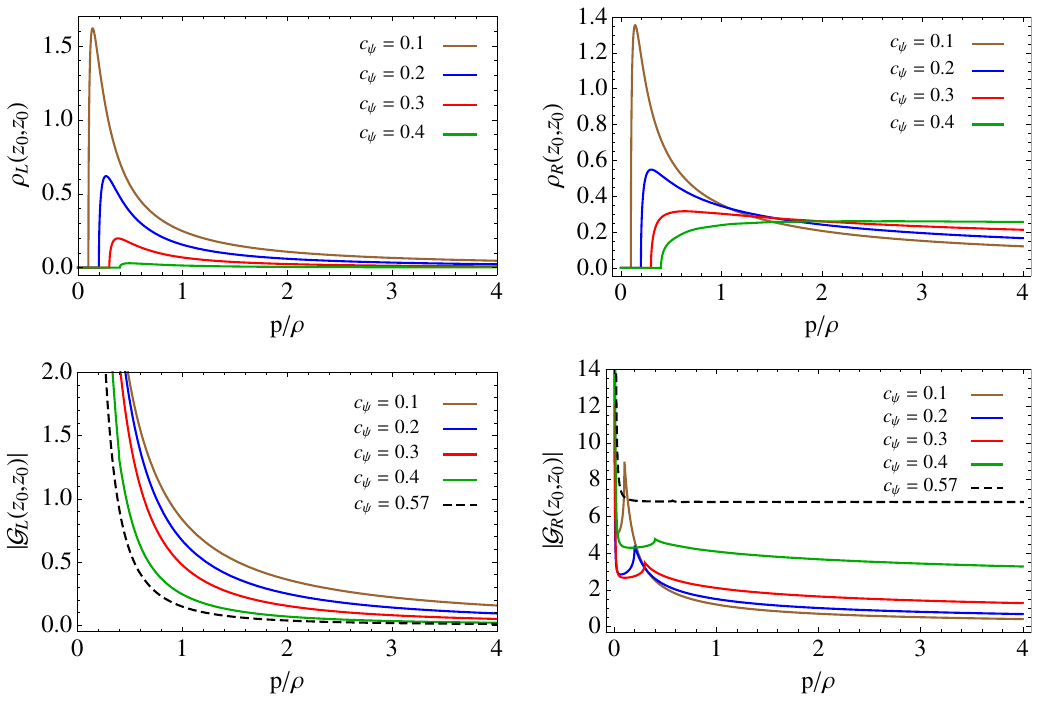
Figure 6 . Upper panels: spectral density for a continuum left-handed fermion, cf. eq. (5.37) (left panel), and a continuum right-handed fermion, cf. eq. (5.39) (right panel). We have used c = 0 : 1 ; 0 : 2 ; 0 : 3 and 0 : 4. Lower panels: absolute value of the Green’s functions for a continuum left-handed fermion (left panel), and a continuum right-handed fermion (right panel). We have used c = 0 : 1 ; 0 : 2 ; 0 : 3 ; 0 : 4 (solid lines) and 0 : 57 (dashed lines). All cases use (cid:15) = (cid:0) 1. The results with (cid:15) = 1 would be the above plots but with L $ R . We have used A 1 = 35 and c =